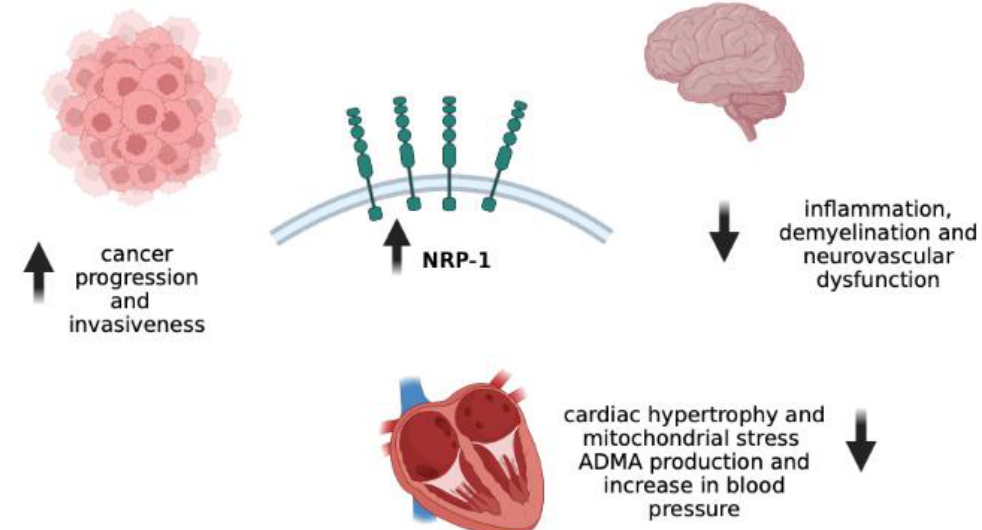
Figure 2. The potential contribution of NRP-1 to human disease. Overexpression of NRP-1 in different clinical contexts may play either a protective or a pathogenic role. In cancer, the receptor may contribute to malignant cell proliferation and metastasis. Conversely, when upregulated in the nervous system, NRP-1 would prevent neuronal dysfunction, inflammation, and demyelination. When expressed on cardiomyocytes and vascular smooth muscle cells, NRP-1 could counteract cardiac hypertrophy and regulate vascular tone. Abbreviations: ADMA: asymmetric dimethylarginine; NRP-1: neuropilin-1. Created with BioRender.com.